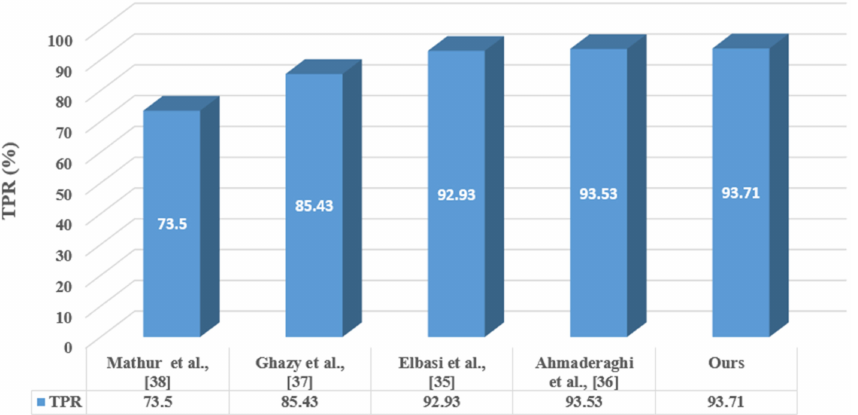
Figure 12. TPR results of different methods comparison.